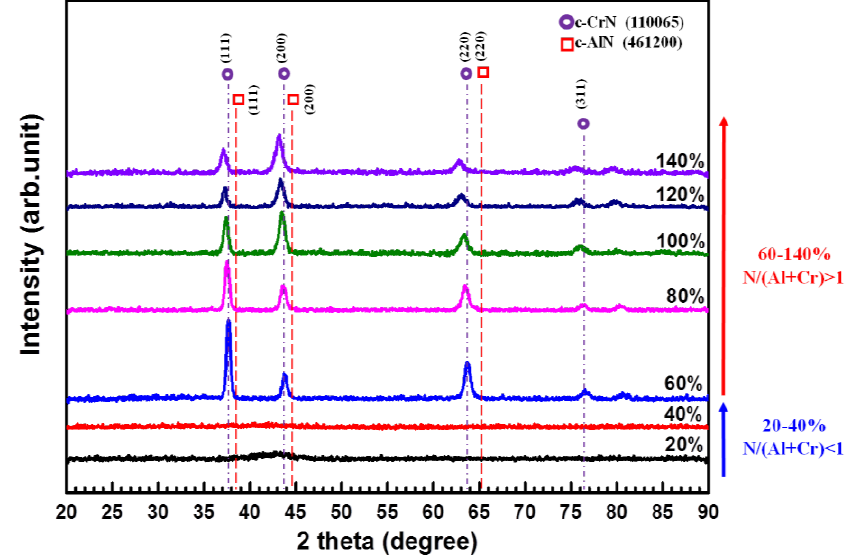
Figure 1. Grazing incidence X-ray diffractometer (GIXRD) profiles of CrAlN layers as a function of N 2 /Ar flow ratio. Figure 2. Selected area electron diffraction (SAED) patterns of CrAlN layers formed under N 2 /Ar flow ratios of 20%, 60%, and 100%. Table 2. Lattice parameters and texture coefficient of CrAlN layer under various N 2 /Ar flow ratios.